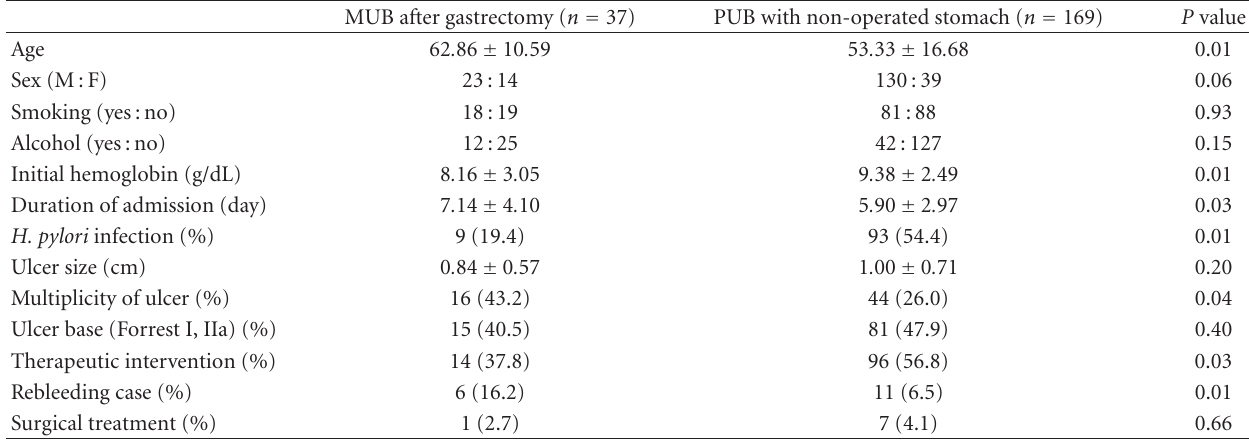
Table 1: Characteristics and clinical outcomes of the patients.